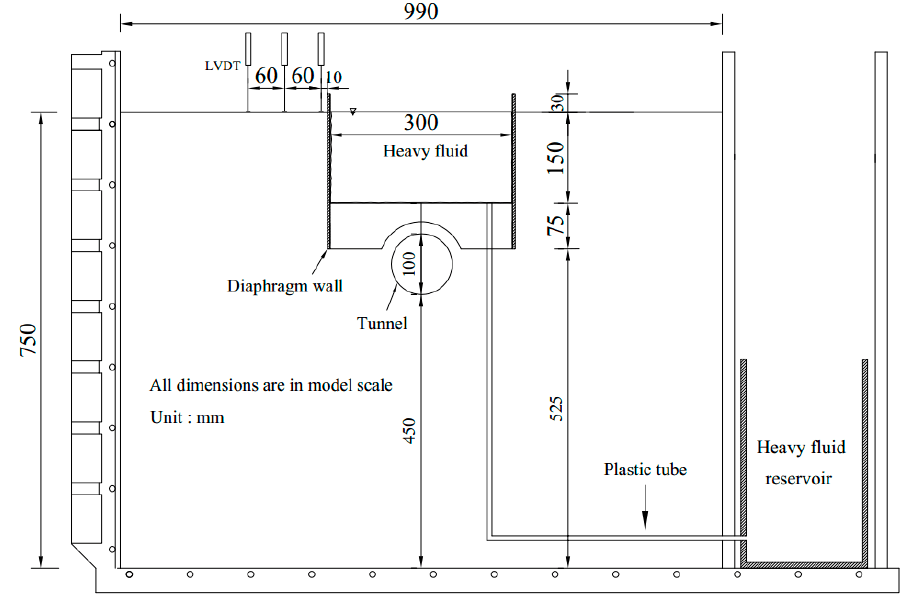
Figure 2. Elevation view of the centrifuge model in model scale (mm) (redraw from Ng et al., 2013) [4].